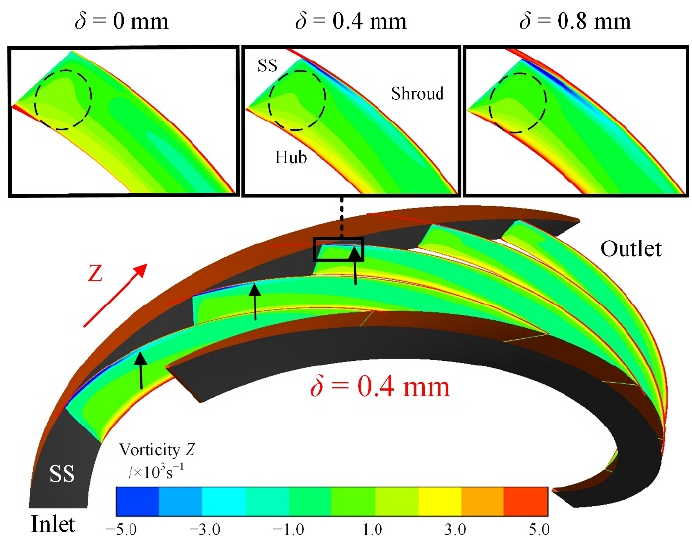
Figure 7. Distribution of the Z component of vorticity on the circumferential sections in the impeller.